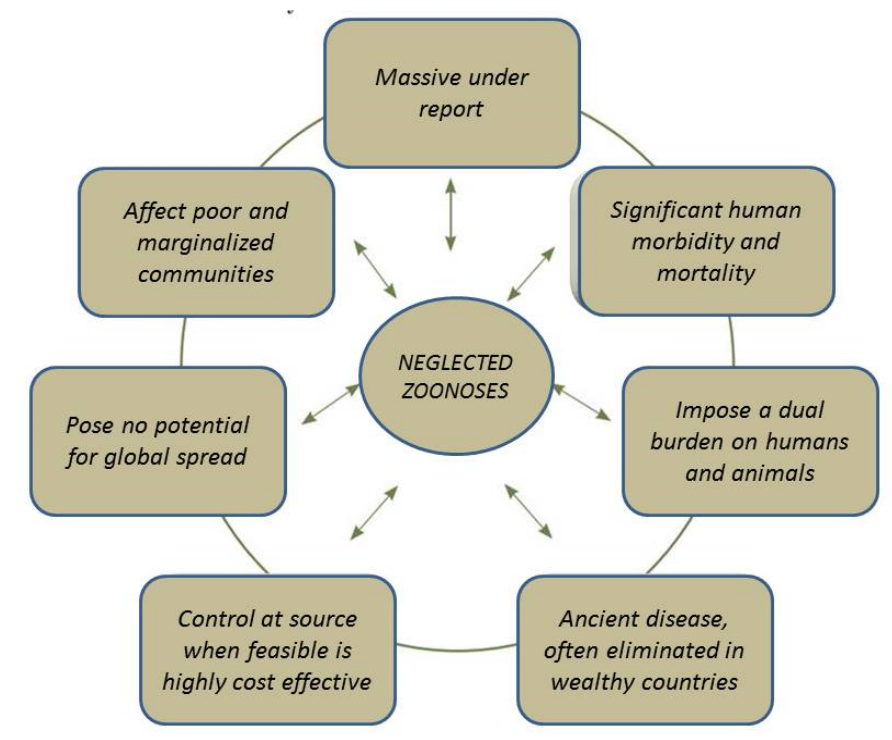
Figure 3. Basic features of neglected zoonotic diseases (reproduced with permission from [202]).